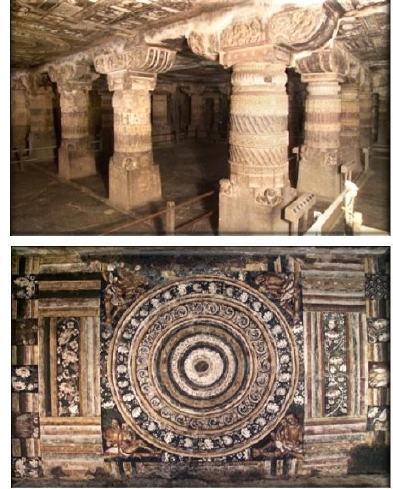
Figure 10. Inner view of cave 2 and its beautiful